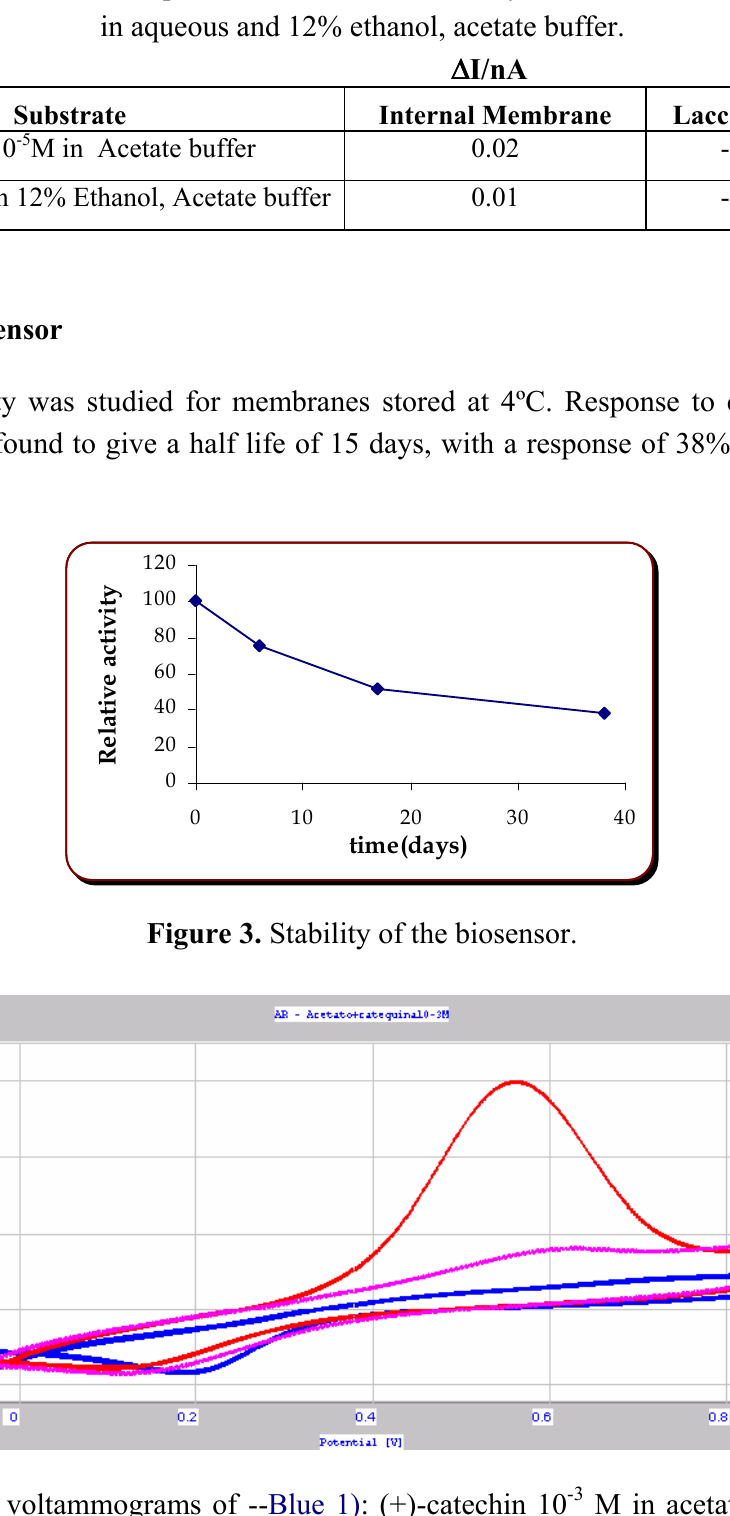
Figure 4. cyclic voltammograms of --Blue 1): (+)-catechin 10 -3 M in acetate buffer pH 4.5 (10mV/s); red 2) : (+)-catechin 10 -2 M in acetate buffer pH 4.5 (10mV/s); pink 3) (+)-catechin 10 -2 M in acetate buffer pH 4.5 (20mV/s). = 94.95 µ A/cm 2 , E I = -23.50 µ A/cm 2 , E = 200.2 mV ; I = 559.2 mV; I = pc1 pc1 pa2 pa2 pc2 -10.95 µ A/cm 2 , E = 120.5 mV; I = 2.74 µ A/cm 2 , E = 584.0 mV, I = -21.25 µ A/cm 2 , pc2 pa3 pa3 pc3 = 143.5 E pc3